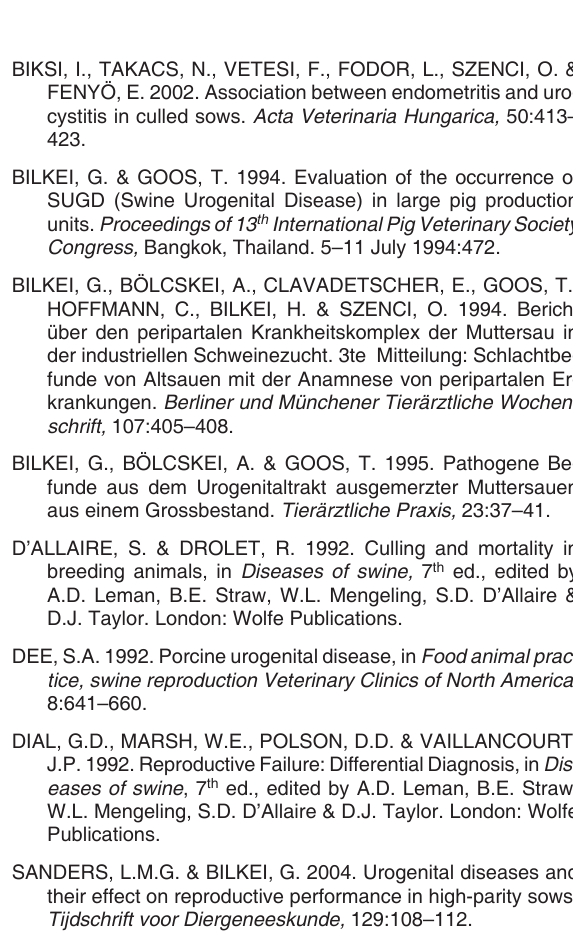
TABLE 1 Gross pathological findings in urogenital organs and mammary glands in sows of different parity, culled due to urogenital in- fections in their previous history (number and percentage of cases in a parity group Pathology Parity 2 Adhesions between oviduct and ovaries Ovarial cysts Multiple tertiary follicles and regressed corpora lutea Ovarian degeneration (small firm ovaries) Distended uterus with purulent or necrotic debris Thickening and ulceration of the uterus wall Adhesive or inflammatory changes on uterine serosa Ulcerations in the vagina or cervix Fibrinopurulent exudate on the vaginal mucosa Cystitis Ulcerations or fibrinopurulent exudate in the bladder Mucosal hyperaemia and congestion in the bladder Pyelonephritis and pathological enlargement and widening of ureterovesical junction Granulomatous mastitis Acute purulent exudative mastitis Chronic purulent exudative mastitis Mammary abscessation Mammary cysts Irregular scattered fibrous foci of mastitis a, b; b, c in a row, the difference is significant ( P < 0.05) a, c in a row, the difference is significant ( P <